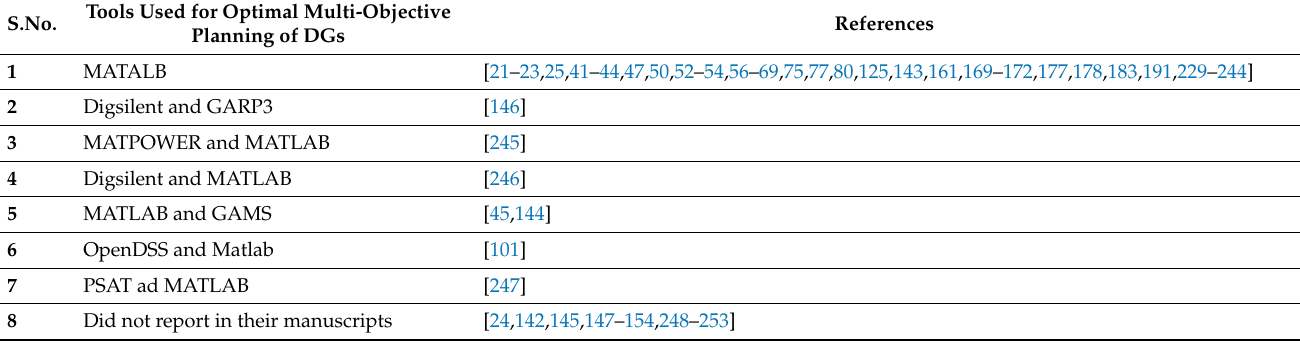
Table 2. Tools used for optimal multi-objective planning of